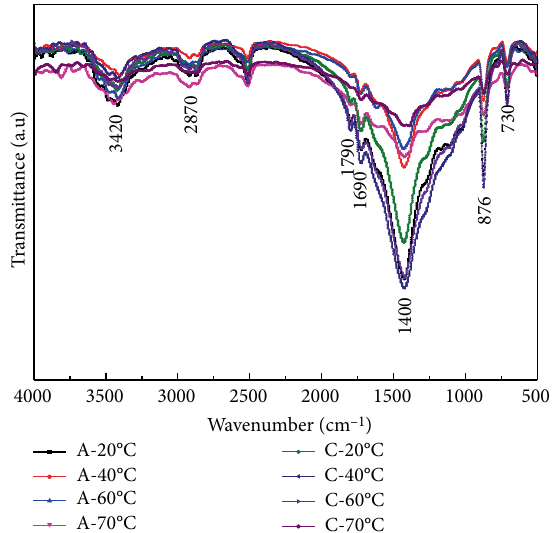
Figure 12: Fourier transform infrared (FTIR) scanning analysis of anchorage at different temperatures.